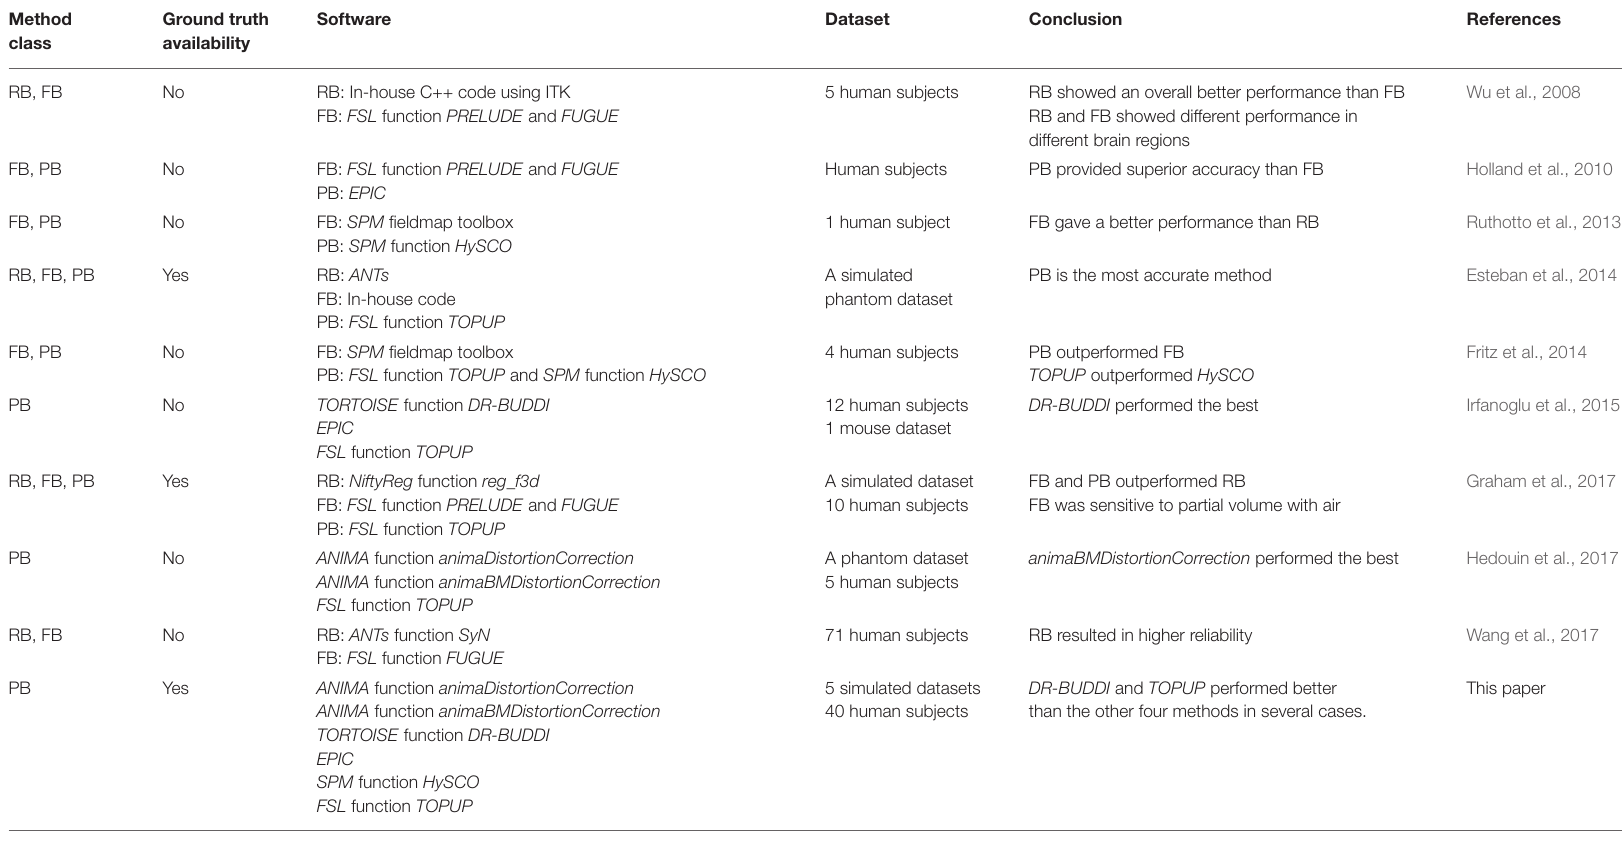
TABLE 2 | A list of susceptibility distortion correction evaluation